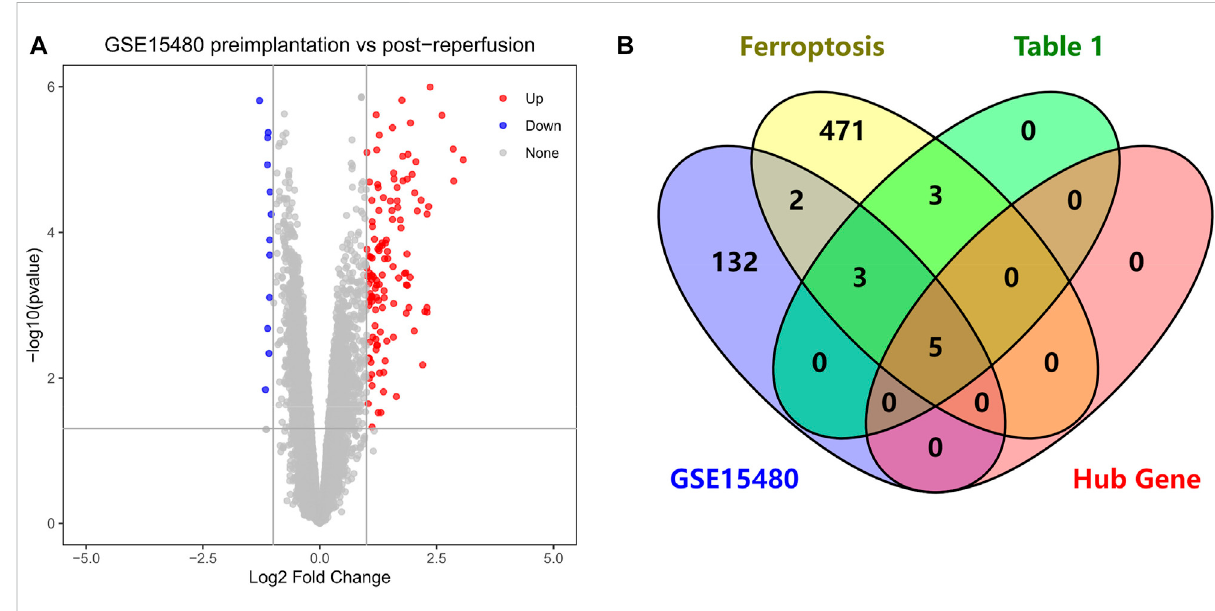
FIGURE 9 (A) Volcano chart mapped by 142 HIRI-related DEGs, (B) Venn chart of “ Ferroptosis ” , “ Table 1 ” , “ GSE15480 ” , “ Hub Gene ”